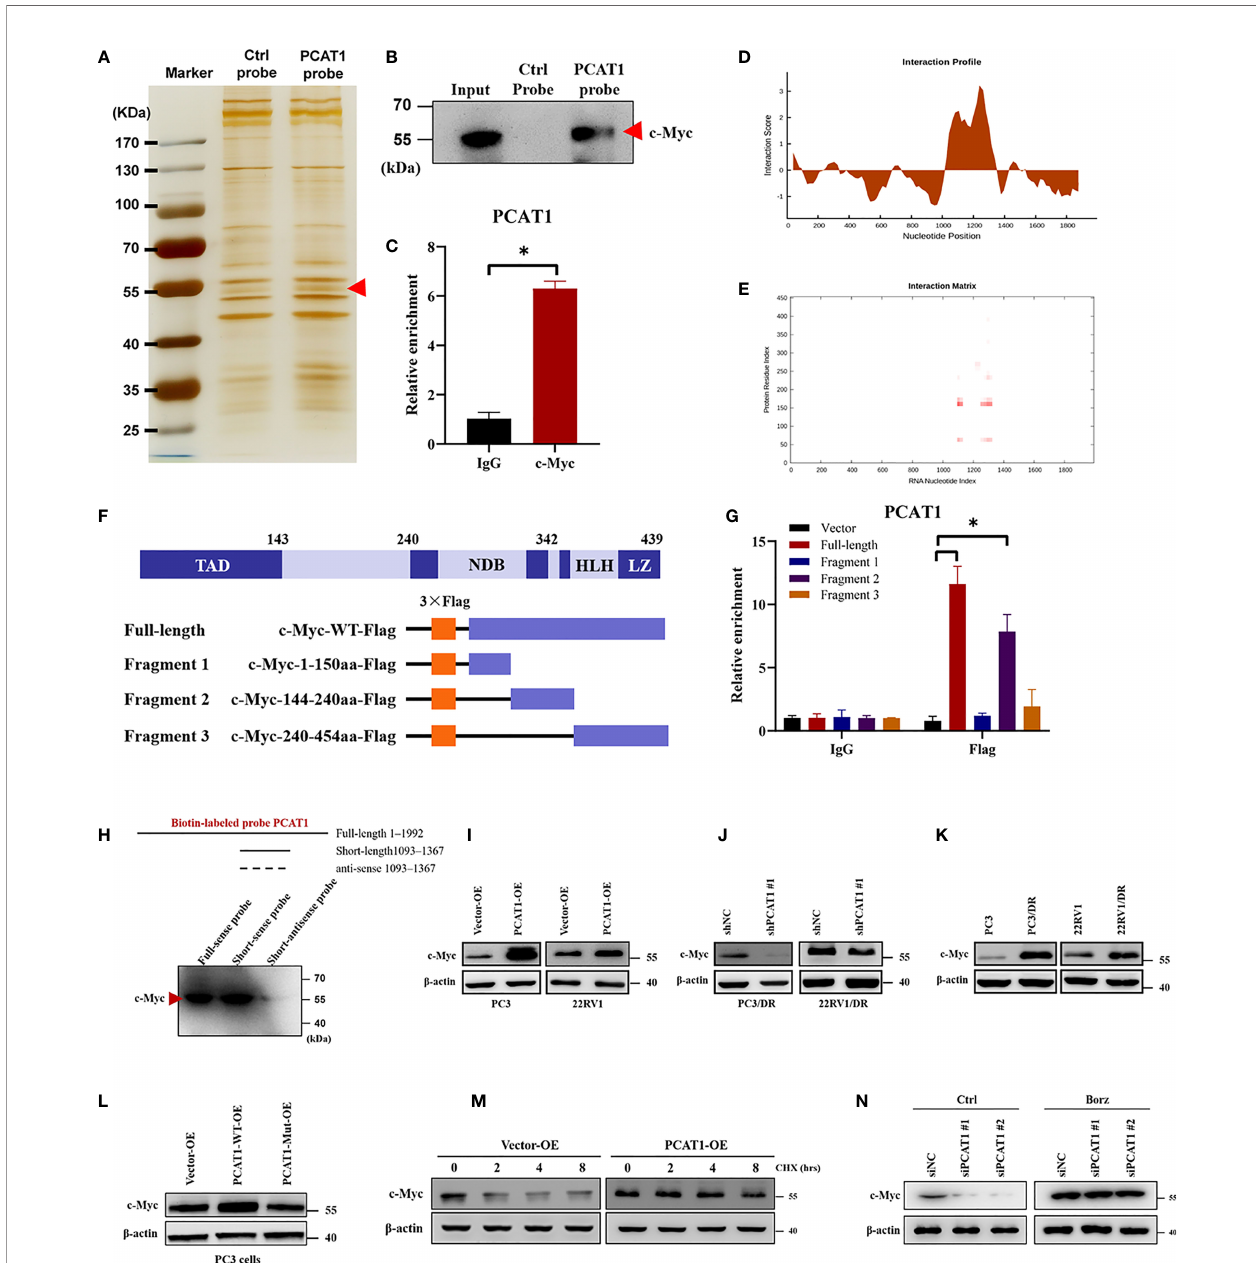
FIGURE 5 | PCAT1 physically interacts with c-Myc and increases its protein stability. (A, B) RNA-protein pulldown experiment was performed using the speci fi c biotin-labeled PCAT1 probe in PC3/DR lysates, followed by silver staining, and the protein bands were analyzed by Western blot. (C) RIP assay was executed in PC3/DR lysates using anti-cMyc or anti-IgG, then the enrichment of PCAT1 was detected by qRT-PCR. (D, E) CatRAPID fragments module prediction of the interaction pro fi le and matrix between PCAT1 and c-Myc protein. (F) The different fragments plasmids of the c-Myc protein were illustrated blew. TAD, transactivation domain. NDB, non-speci fi c DNA binding domain. HLH, helix loop helix domain. LZ, leucine zipper domain. (G) The interaction of c-Myc protein regions with PCAT1 in PC3 cells was determined by using a RIP assay. (H) RNA pulldown and Western blot were used to verify the possible binding of c-Myc protein by using a short biotin-labeled probe containing 1093 – 1367 nt of PCAT1. ( (I, J) Western blot was used to evaluate the protein level of c-Myc upon PCAT1 overexpression or knockdown. (K) The protein level of c-Myc was assessed by Western blot in DTX-resistant PCa cells and their sensitive cells. (L) The relative protein level of c-Myc was evaluated in PC3 cells after transfected with PCAT1 wild-type or mutant plasmids. (M) Western blot was used to detect the c-Myc protein level in PCAT1- overexpressed PC3 cells under protein synthesis inhibitor CHX treatment. (N) The effect of proteasome inhibitor Borz on the change in the c-Myc protein level mediated by PCAT1 knockdown as detected by Western blot The data are presented as the means ± S.D. of at least three independent experiments. * P